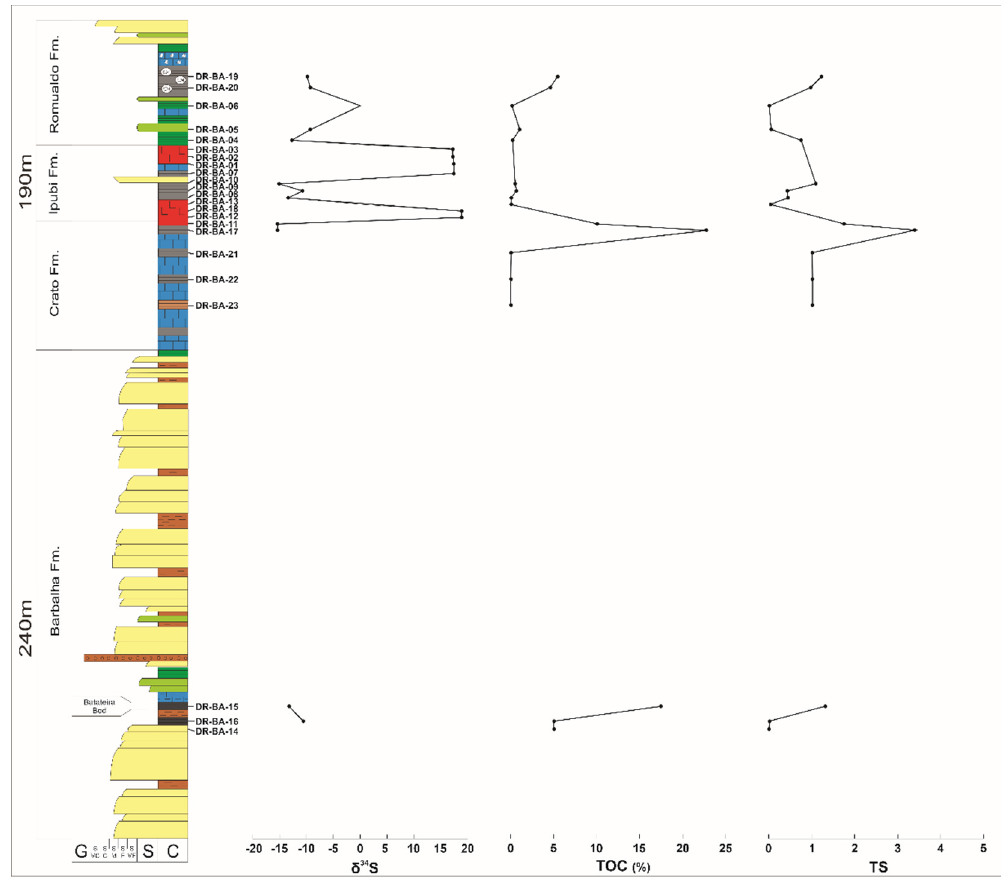
Figure 7. Compared variations between sulfur isotope ( δ 34 S), total organic carbon (TOC), and total sulfur (TS) values from samples of the Santa Group. See text for explanation.